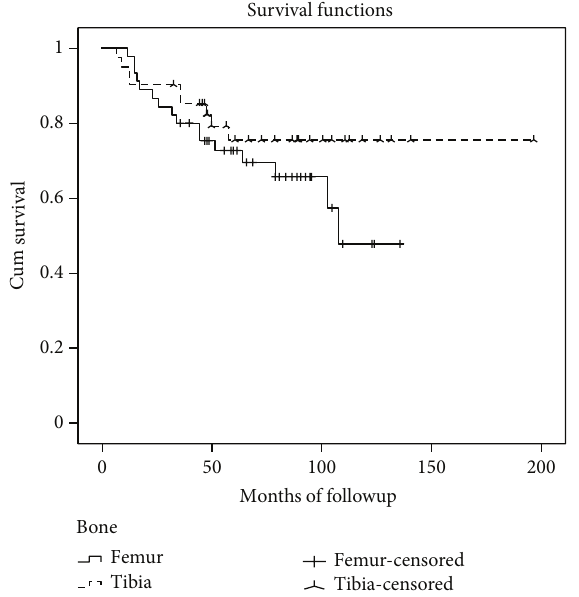
Figure 5: Kaplan-Meier curve showing the differences in APC survivorship according to the affected bone.